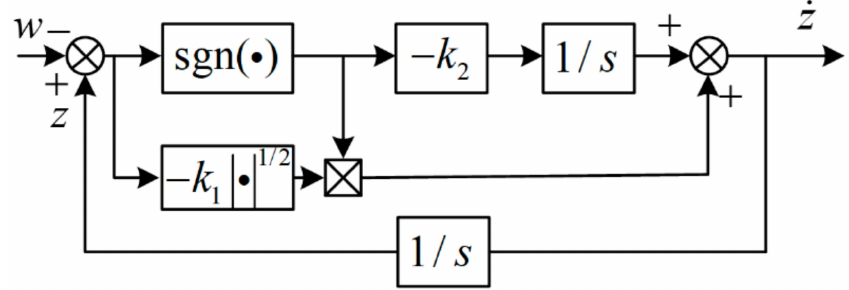
Figure 1. Schematic diagram of the robust